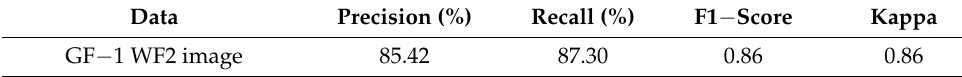
Table 7. Red tide detection accuracy of RDU − Net using GF − 1 WF2 image.